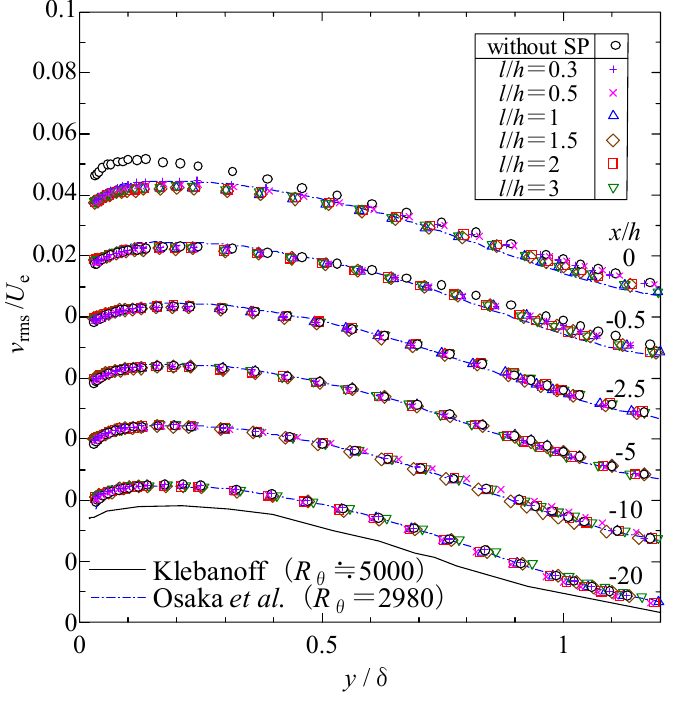
Fig. 3 Normal turbulent intensity profiles